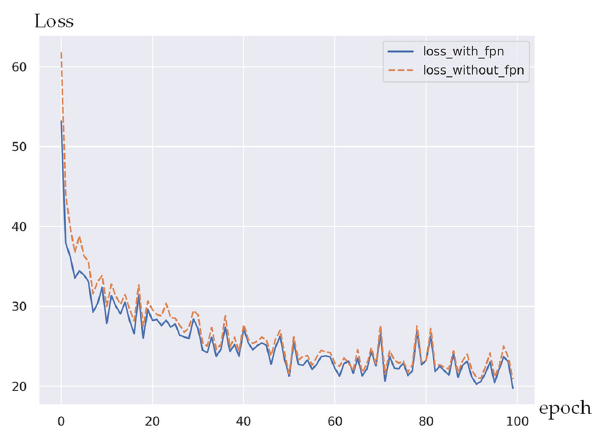
Figure 10. Comparison between the speed of loss reduction with and without Hough FPN.